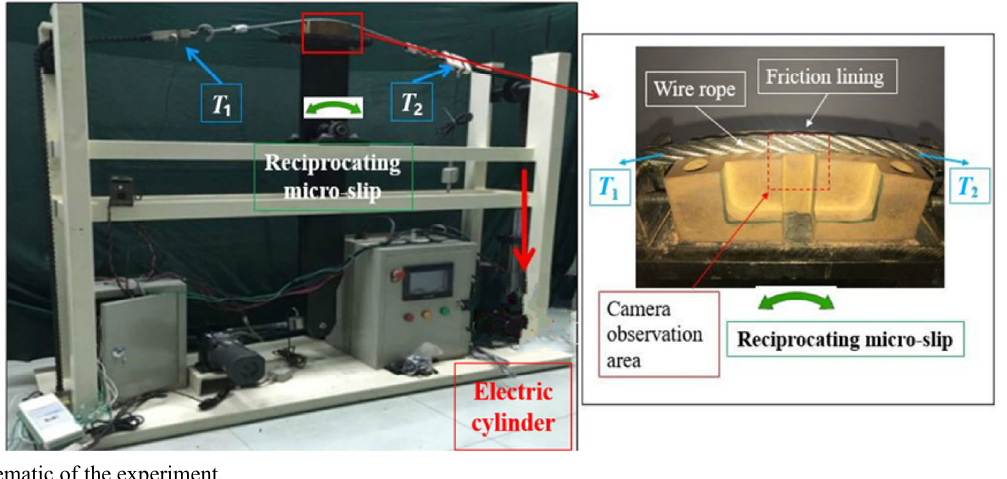
Fig. 2 Schematic of the experiment.